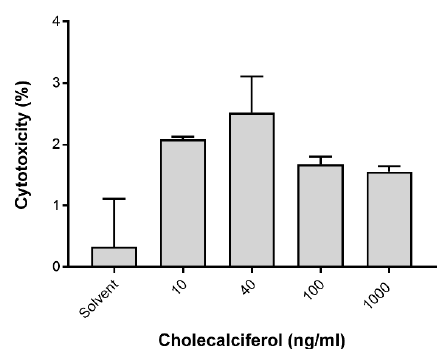
Figure 7. Analysis of necrotic cell death assessed by the lactate dehydrogenase (LDH) assay. Insignificant changes in LDH activity between the control and experimental cultures were identified. Assays were performed on three biological replicates, and each replicate was technically triplicated. Values are expressed as mean ± SEM ( p < 0.05 was considered statistically significant).